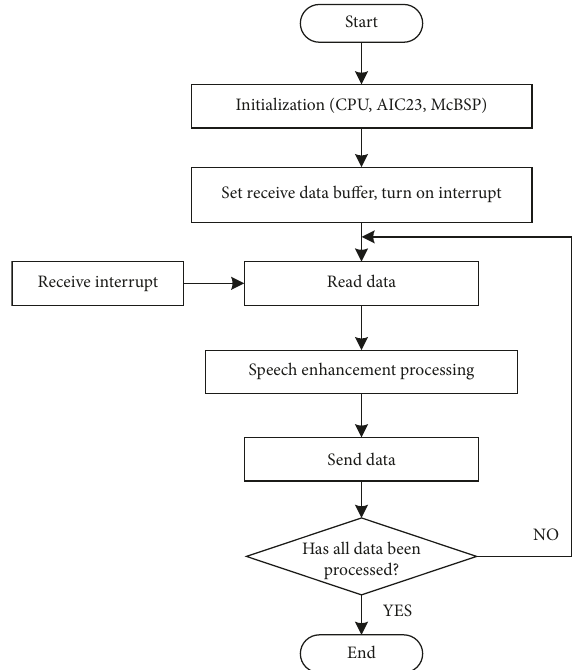
Figure 7: System main program flow